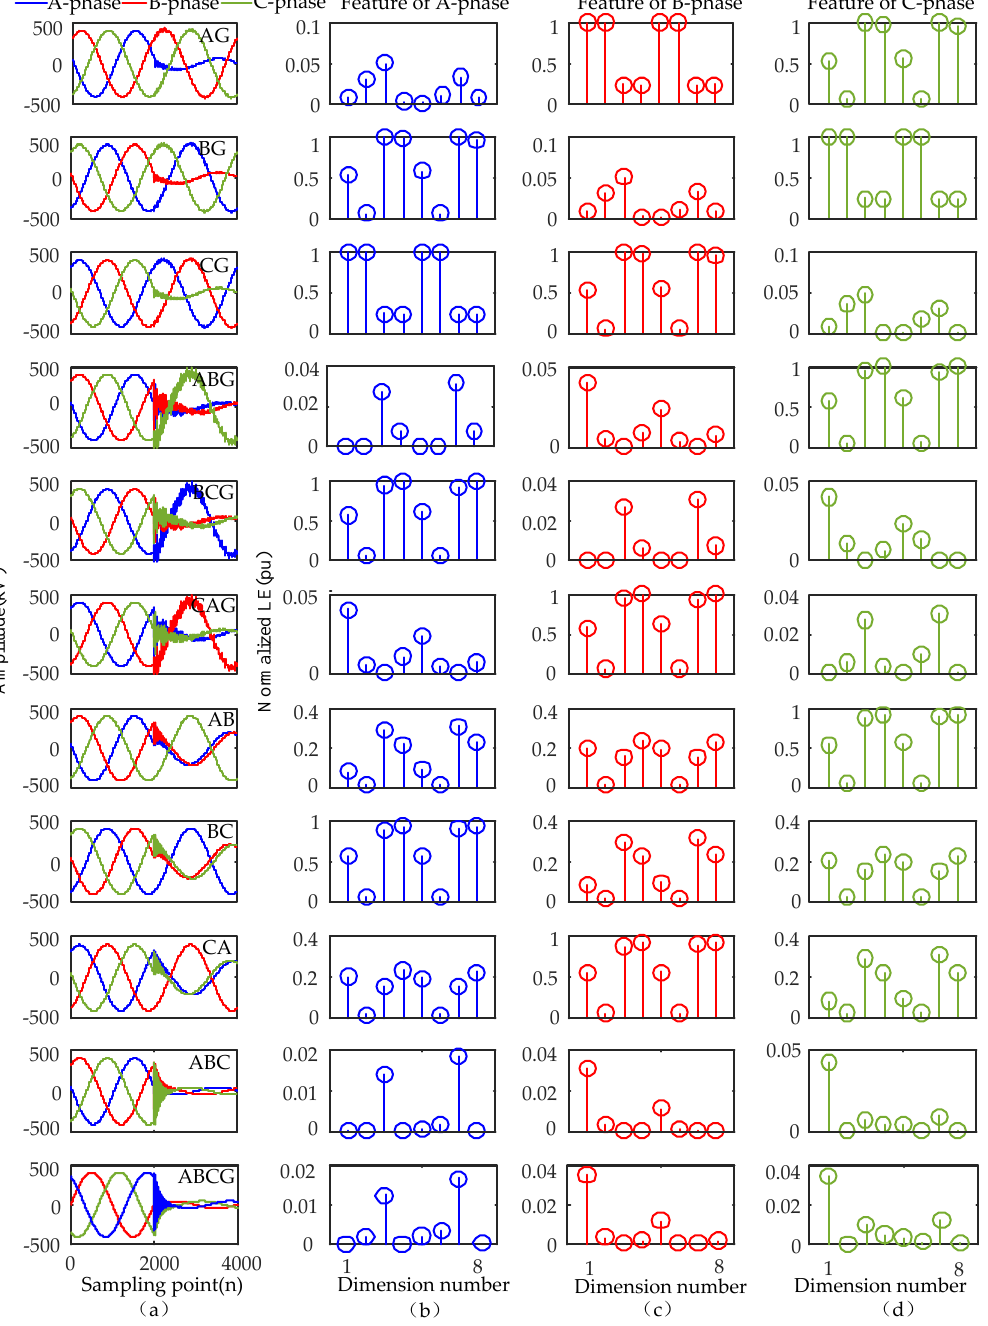
Figure 10. Three-phase voltage and its LE features of different short-circuit faults are listed as: ( a ) three-phase voltage signals of 10 types of faults; ( b ) LE features corresponding to A-phase voltage signal; ( c ) LE features corresponding to B-phase voltage signal; ( d ) LE features corresponding to C-phase voltage signal.